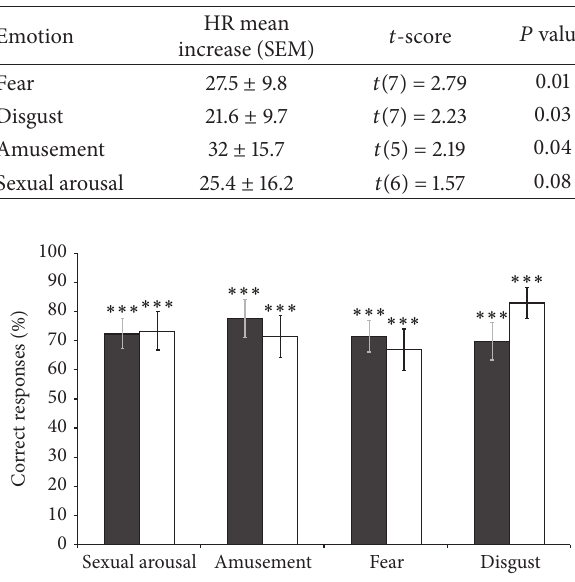
Table 2: Heart rate increases during the movie clips.